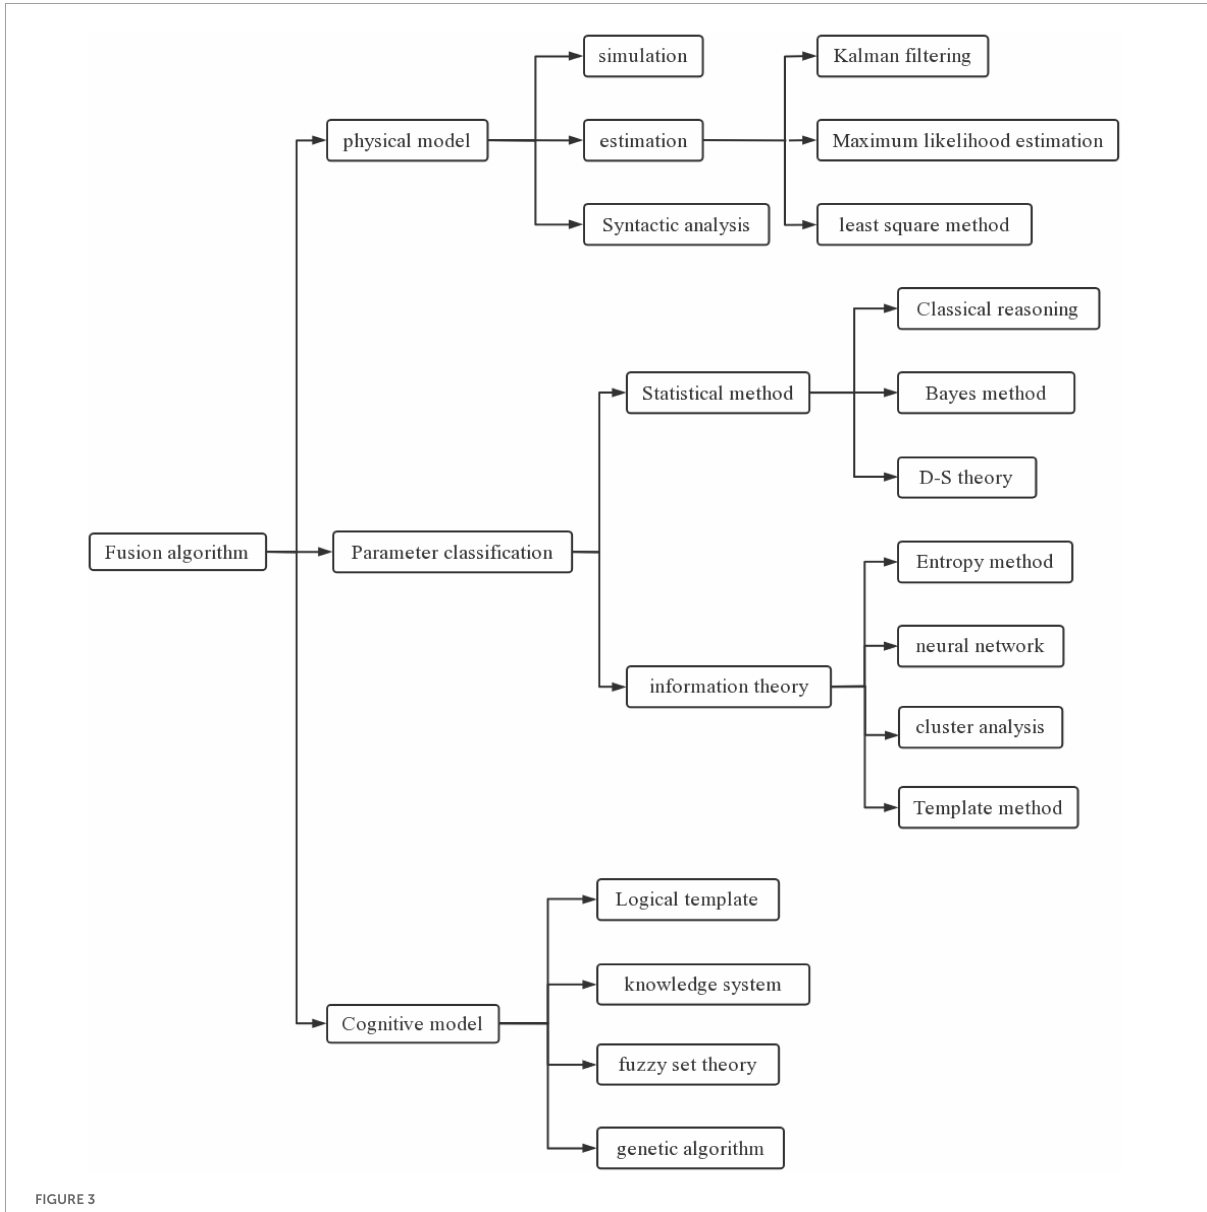
FIGURE3 Conceptual classification of fusion